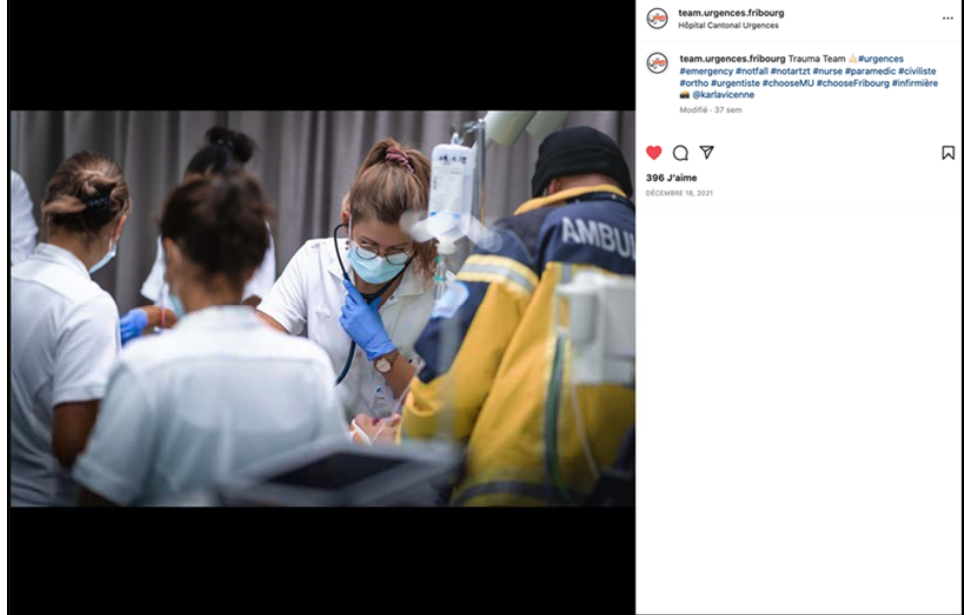
Figure 5. Promoting the work of teams at Fribourg hospital (screenshot).